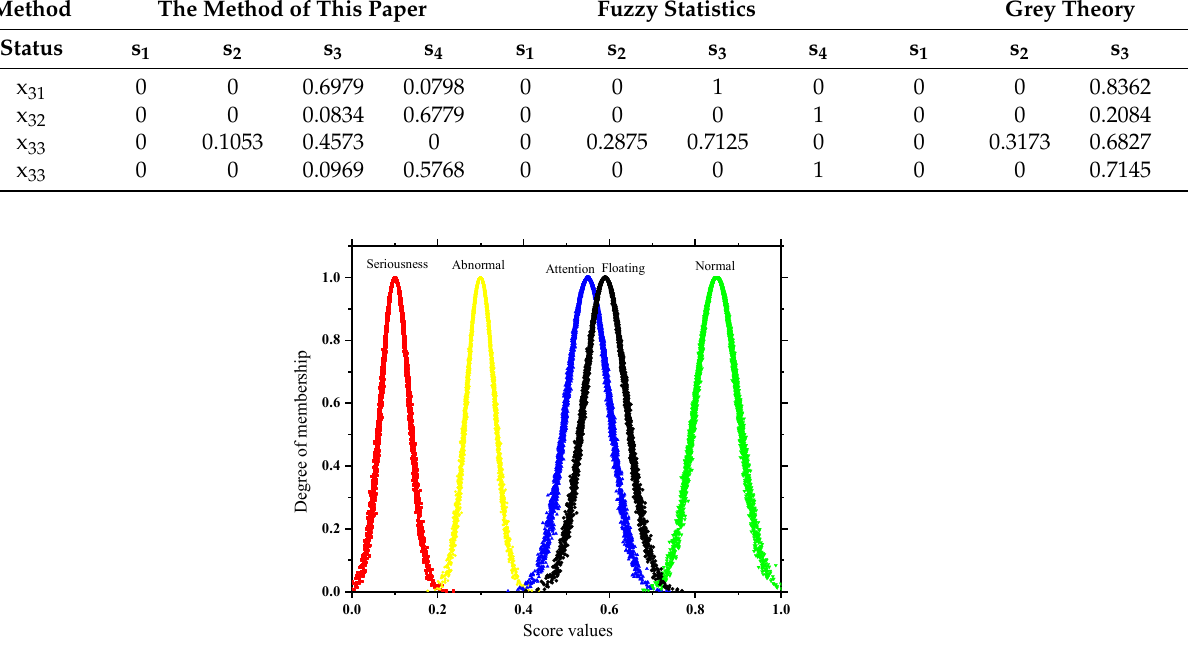
Figure 8. Membership degree of x 31 .